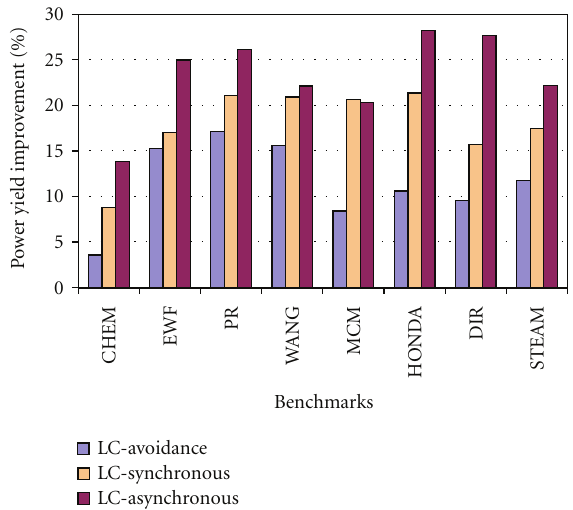
Figure 13: Power yield improvement against deterministic worst- case approach with di ff erent level conversion strategies and timing yield constraint of 95%.